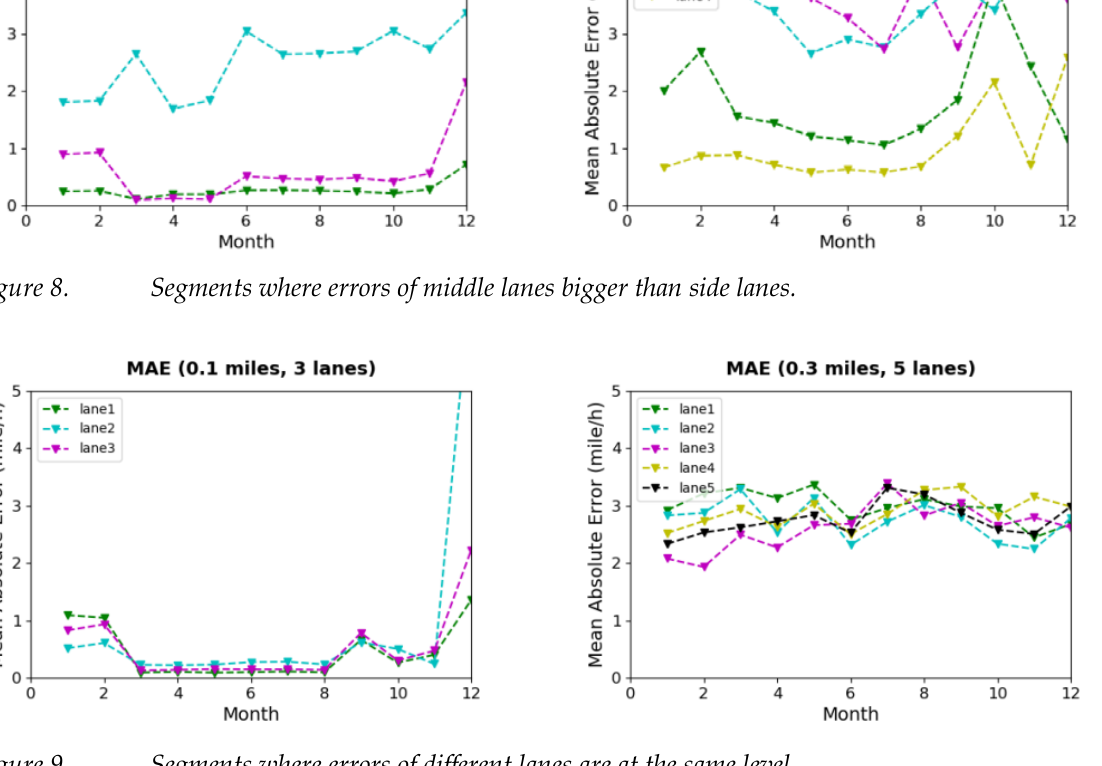
Figure 9. Segments where errors of different lanes are at the same